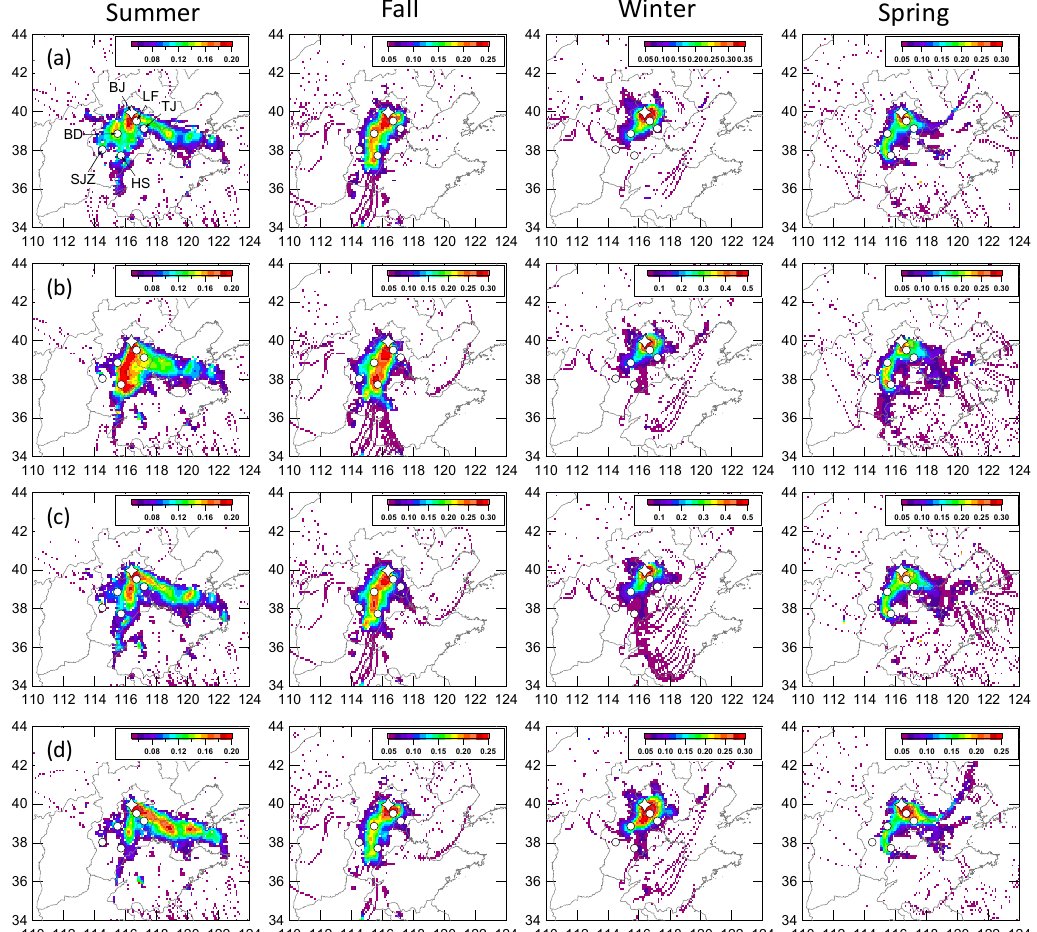
Figure 12. PSCF of NR-PM 1 species during four seasons: (a) organics; (b) sulfate; (c) nitrate; (d) chloride. The cities marked in each panel are Beijing (BJ), Tianjing (TJ), Langfang (LF), Baoding (BD), Shijiazhuang (SJZ), and Hengshui (HS). The color scales indicate the values of